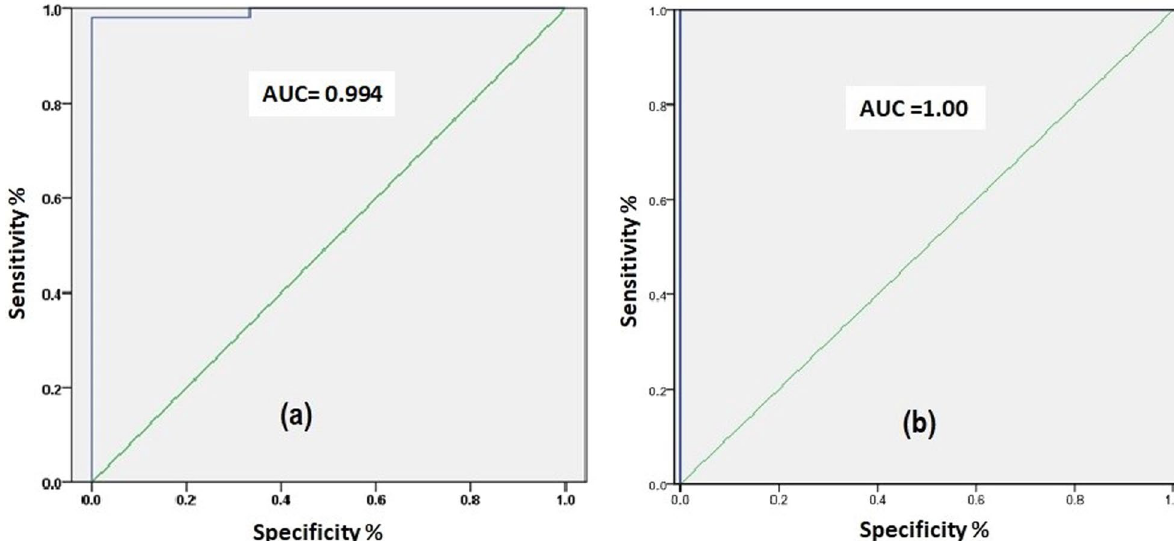
Fig. 1 Roc curves for sensitivity and specificity of a GSDMD for detection of exudative Pleural effusion and b VEGF for detection of malignant pleural effusion